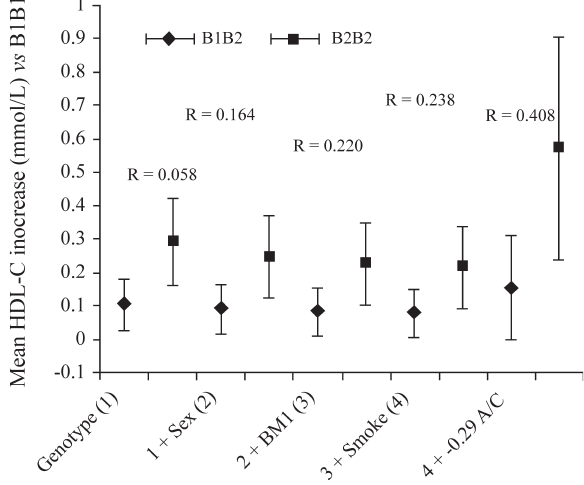
Figure 1 - Sensitivity analysis. Regression coefficient and 95% confi- dence intervals (CI) shown for the CETP gene TaqI B1B2 and B2B2 al- leles compared with the B1B1 allele when each indicated variable was progressively included into the linear regression modes. Models are as fol- lows: model 1, TaqI genotype; model 2 = model 1 + sex; model 3 = model 2 + BMI; model 4 = model 3+ tobacco smoking; and model 5 = model 4+ -629A/C genotypes. R 2 values are included to show the variability ac- counted for in each regression model. *The p values were less than 0.05 except for the BMI and AC alleles.